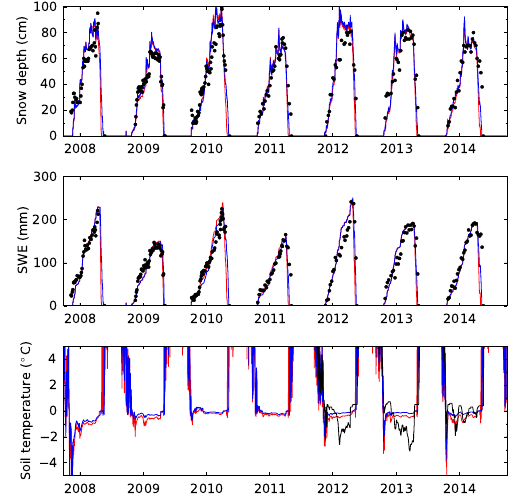
Figure 8. Crocus simulations with the above-canopy (red lines) and below-canopy (blue lines) driving datasets, compared with mea- surements (black dots and lines) of snow depth, SWE and soil tem- perature at 10cm depth. For clarity, only manual measurements of snow depth and SWE are shown. Figure 9. Profiles of snow temperature and density from Cro-